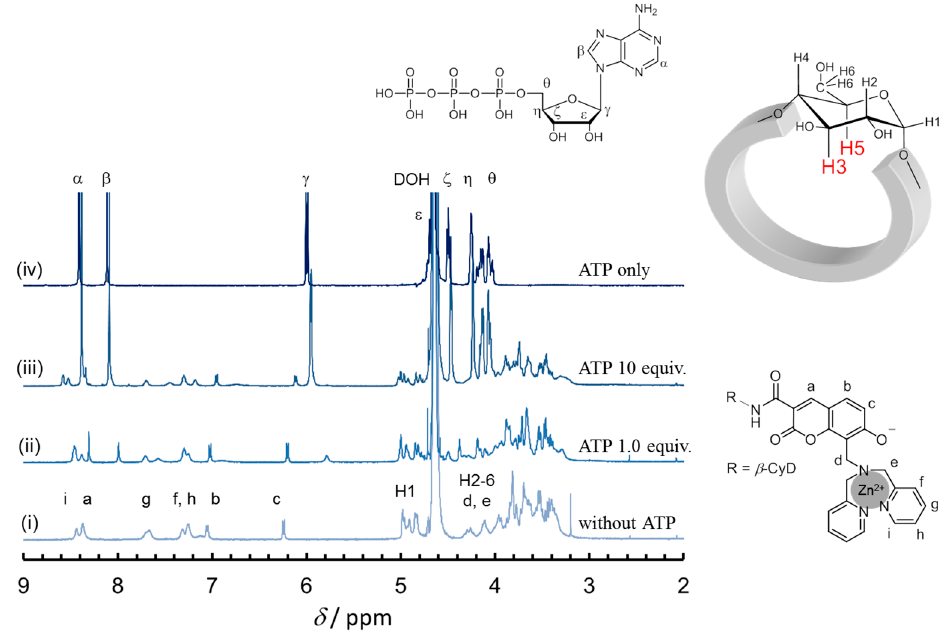
Figure 6. 1 H NMR spectra of complex ATP/ Zn·1 β and ATP (500 MHz, solvent: D 2 O). ( i ) [ Zn·1 β ] = 0.5 mM, ( ii ) [ Zn · 1 β ] = 0.5 mM, [ATP] = 0.5 mM, ( iii ) [ Zn · 1 β ] = 0.5 mM, [ATP] = 5.0 mM, ( iv ) [ATP] = 10 mM.